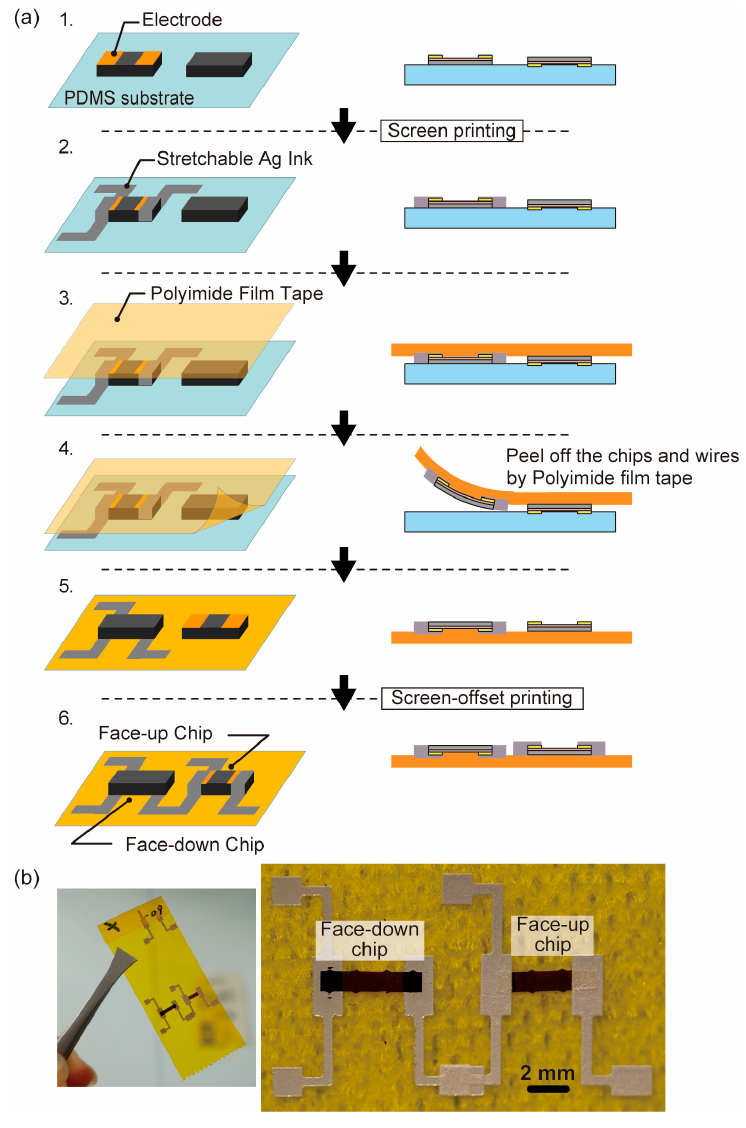
Figure 6. ( a ) Chip transfer and screen-offset printed wiring process of face-up and face-down chip mixture situation. ( b ) Photograph of the implemented face-up and face-down 5- μ m-thick piezoresistive Si chips on polyimide film